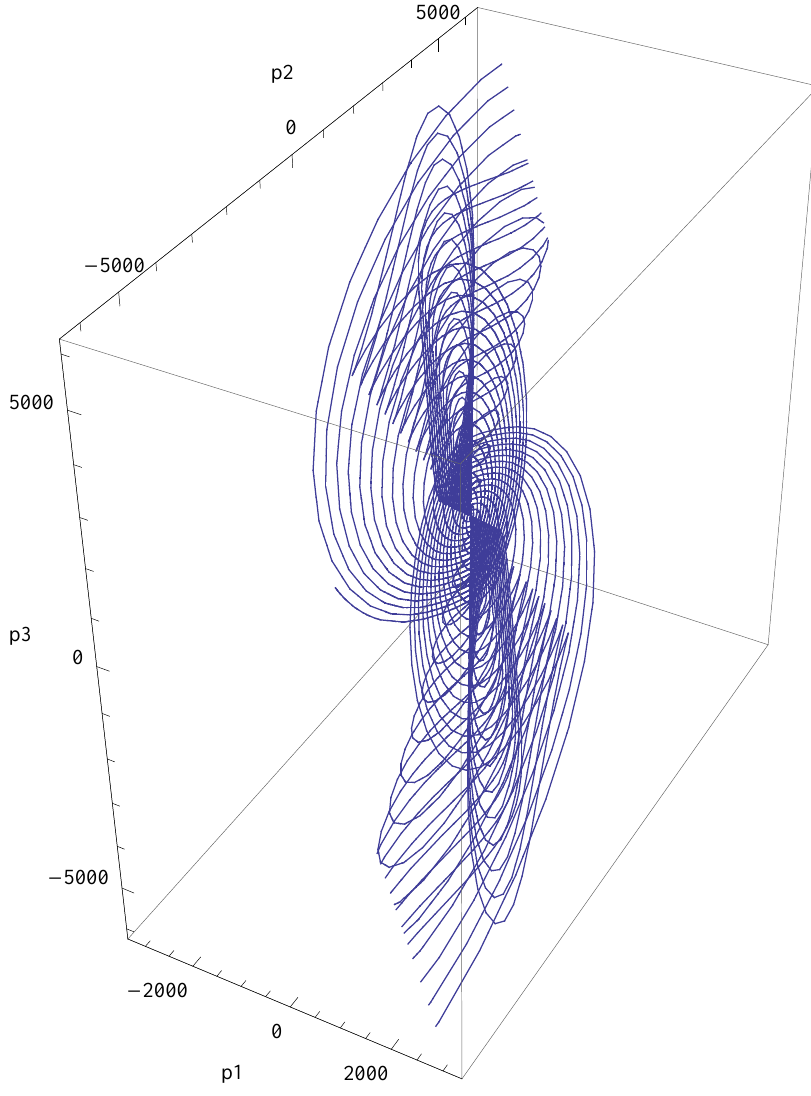
Figure 2: The Lie-Trotter integrator of the system (3), projection on ( Op 1 p 2 p 3 ) plane ( a 1 = 10, a 2 = 2, a 3 = 3, x 1 (0) = x 2 (0) = x 3 (0) = p 1 (0) = p 2 (0) = p 3 (0) = 1